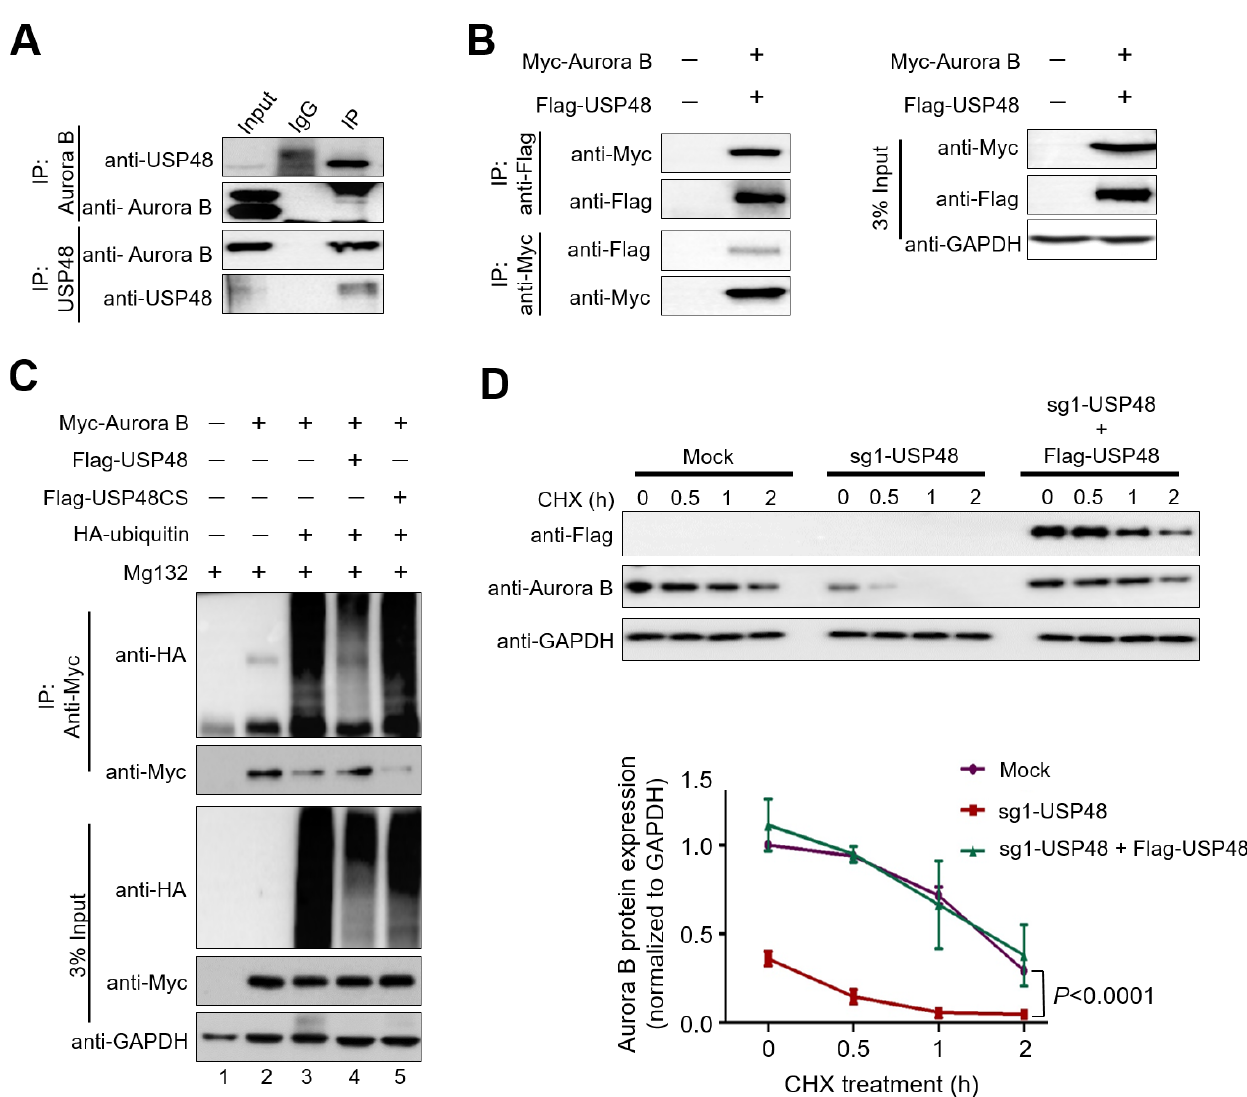
Figure 3. USP48 interacts, deubiquitinates, and extends Aurora B protein half-life. ( A ) The endogenous interactions between the USP48 and Aurora B proteins were examined by immunoprecipitation (IP) experiments in HeLa cells. Cell lysates from HeLa cells were immunoprecipitated and immunoblotted with specific USP48 or Aurora B antibodies as indicated. ( B ) Exogenous IP experiments to demonstrate the interaction between Myc-Aurora B and Flag-USP48 were performed in HEK293 cells. Samples were immunoprecipitated and immunoblotted using either anti-Flag or anti-Myc antibodies as indicated. GAPDH was used as a loading control. ( C ) Myc-Aurora B and HA-ubiquitin were co-transfected along with either Flag-USP48 or Flag-USP48CS in HEK293 cells. The ubiquitination level of Aurora B protein was confirmed by performing IP with an anti-Myc antibody and immunoblotting with the anti-HA (ubiquitin) and anti-Myc antibody as indicated. ( D ) The cycloheximide assay was performed to demonstrate the half-life of endogenous Aurora B protein in cells transfected with mock control, sgRNA1 targeting USP48 , and upon the reconstitution with Flag-USP48 in sgRNA1 targeted USP48 HeLa cells. Experiments were performed in triplicates and band intensities were estimated using ImageJ software with reference to the GAPDH control band and graphically represented. Two-way ANOVA followed by Tukey’s post hoc test was used and the p values are represented.